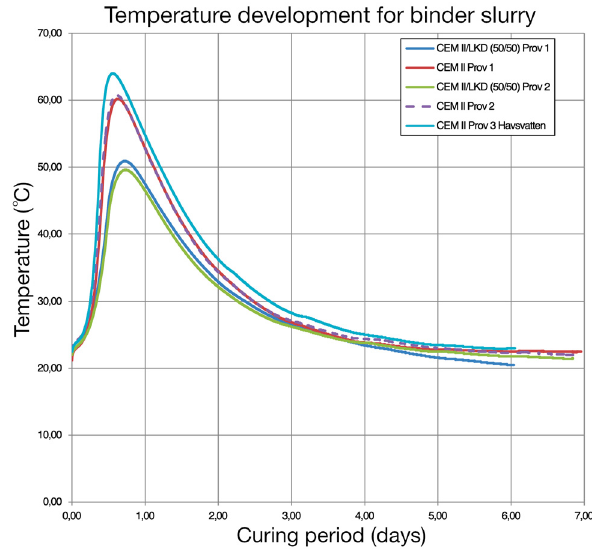
Figure 14: Heat development in two binder combinations over